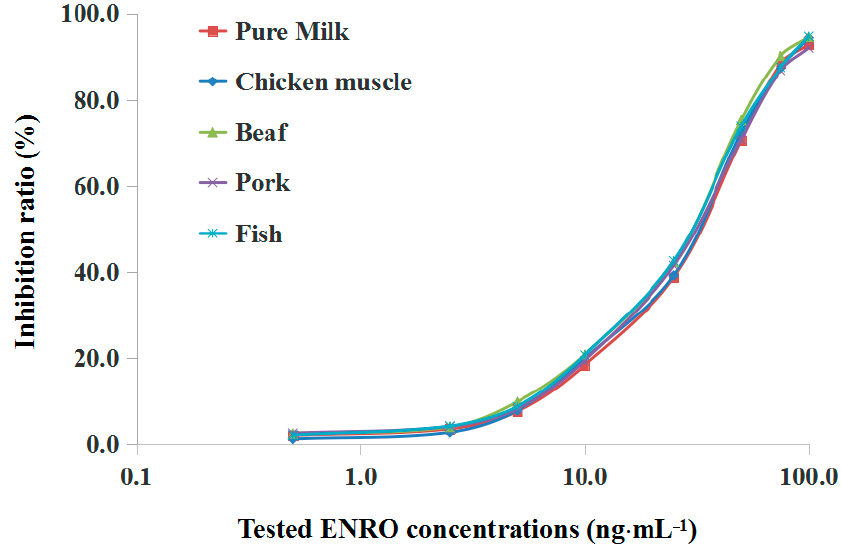
Figure 8. Calibration curves of chosen matrix samples using the developed SPR immunosensor.